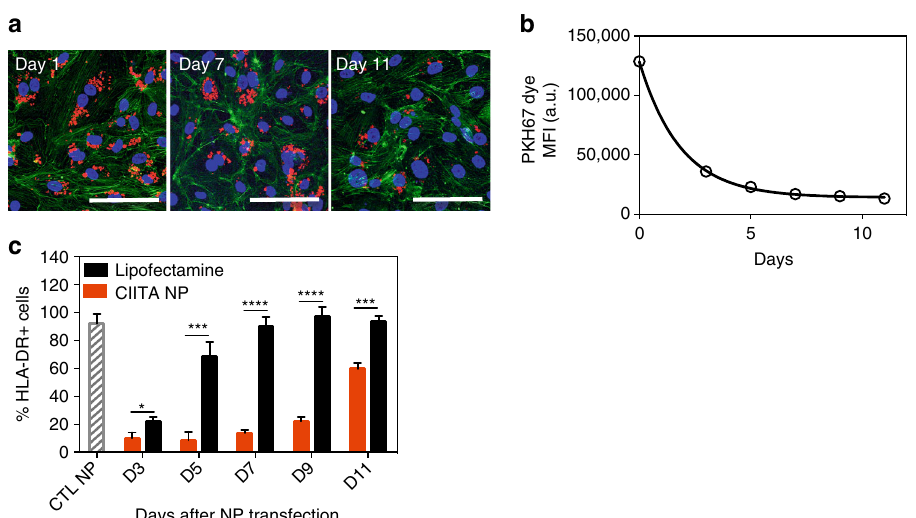
Fig. 3 Long-term NP retention and MHC class II knockdown in HUVECs. a siRNA-loaded nanoparticles ( red ) are retained in HUVECs for at least 11 days. Cells were stained using phalloidin ( green ) and dapi ( blue ) and imaged using a confocal microscope ( scale bar : 100 μ m). b Dilution of fl uorescence over 11 days in HUVECs pre-labeled with PKH67 tracer (Sigma). Labeled HUVECs were seeded in a 24-well plate at a concentration of 10 5 cells per well. Cell tracer fl uorescence was measured using a fl ow cytometer. c Durable knockdown of HLA-DR protein on HUVECs for 11 days. HUVECs were treated with siRNA-loaded nanoparticles or Lipofectamine for 6 h and cultured for up to 11 days. At days 3, 5, 7, 9, and 11, cells were harvested and surface HLA-DR expression was quanti fi ed using a fl ow cytometer. Data shown is mean ± SD ( n = 4). ** p < 0.01, *** p < 0.001, **** p < 0.0001 by Student ’ s t-